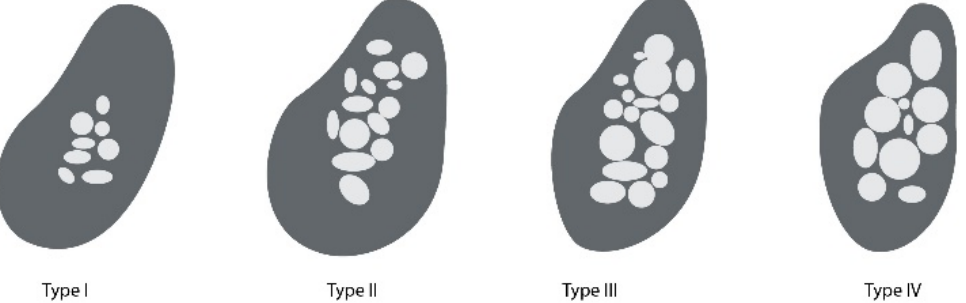
Figure 2. Lekholm and Zarb classification: Type I, whole bone is built of very thick cortical bone; Type II, thick layer of cortical bone surrounds the core of dense trabecular bone; Type III, thin layer of cortical bone surrounds the core of trabecular bone of good strength; Type IV, very thin layer of cortical bone with low density trabecular bone of poor strength.